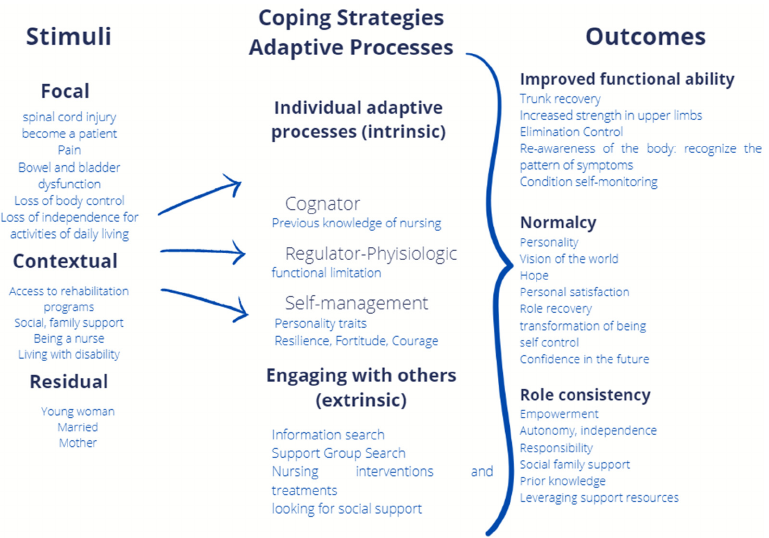
Figure 1. Identification of experiences in adaptation to spinal cord injury in relation to the TRM concepts of adaptation to chronic health conditions. (Fernandez-Moya, Moreno-Fergusson 2022).